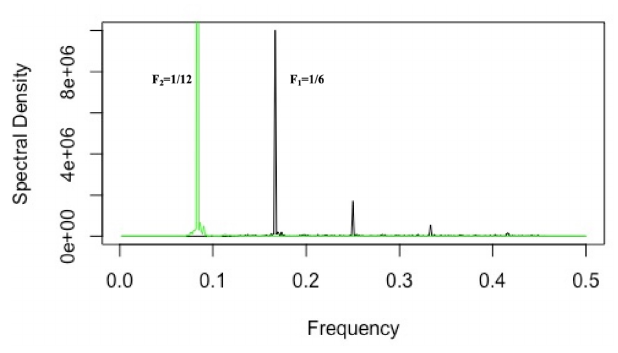
Figure 17. Rainfall EAWD 1 (black line) and EAWD 2 (green line) spectral contents.